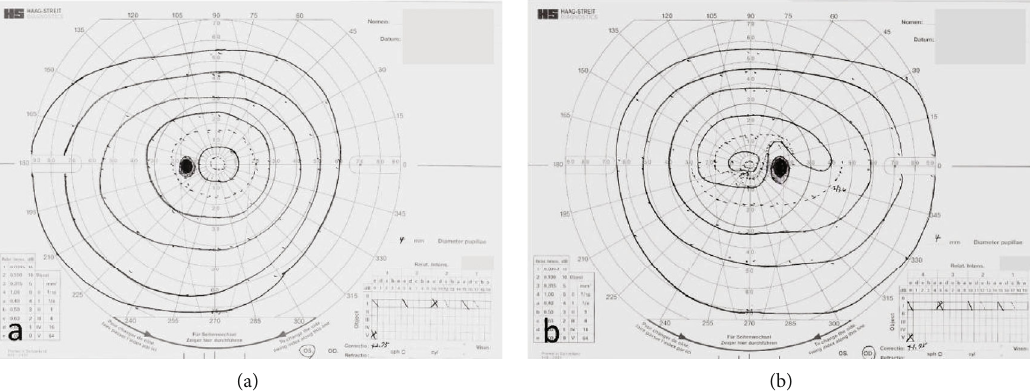
Figure 2: Goldmann perimetry of the left (a) and right (b) eyes. Note the inferior altitudinal visual fi eld defect with I/2 isopter in the right eye.